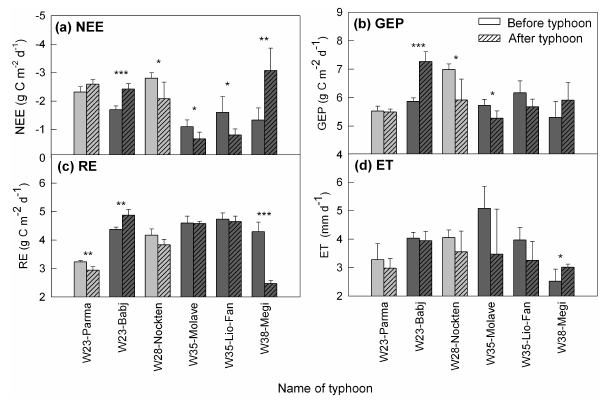
Figure 4. Average daily (a) net ecosystem CO 2 exchange (NEE), (b) gross ecosystem production (GEP), (c) ecosystem respiration (RE), and (d) evapotranspiration (ET) before and after six typhoons made landfall. Dark grey bars represent the values during the ty- phoons that occurred at Yunxiao, and light grey bars are for those during the typhoons that occurred at Gaoqiao. *, **, and *** stand for significant level P < 0 . 05, P < 0 . 01, and P < 0 . 001, respec-